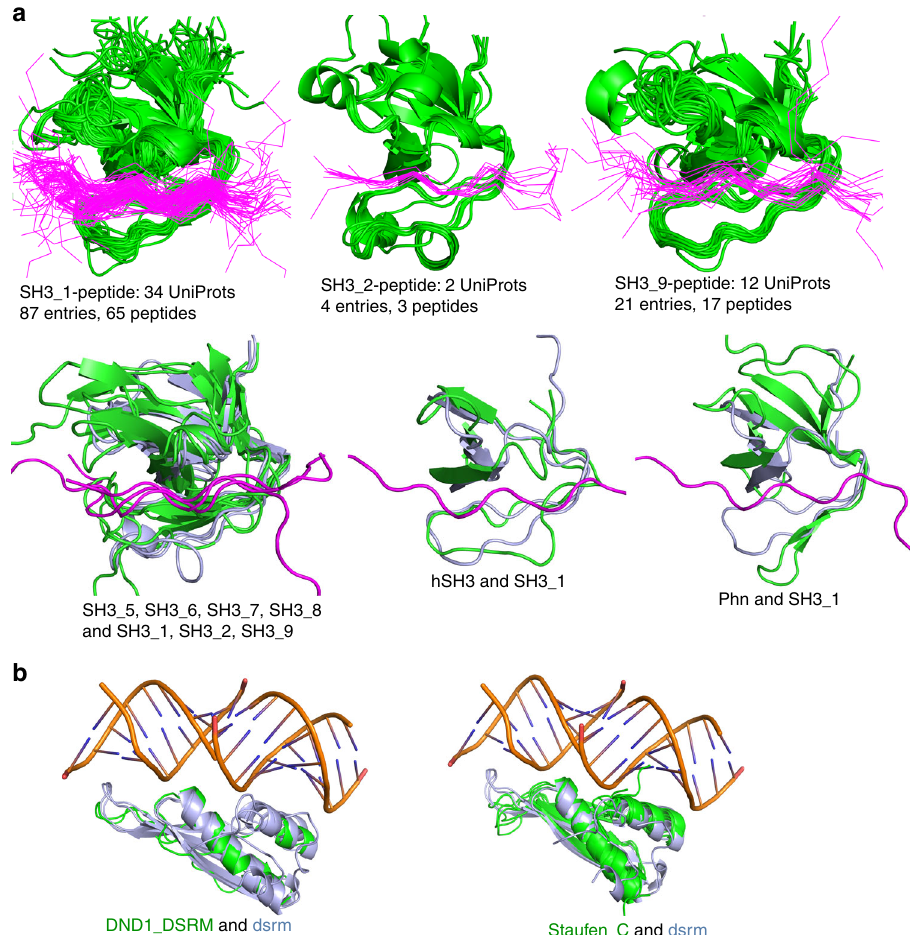
Fig. 8 Peptide-binding and DNA-binding to Pfams in clans. a Models of peptide binding to Pfams in the SH3 clan. First row: SH3_1/peptide interface cluster, SH3_2/peptide cluster and SH3_9/peptide cluster. These clusters in the SH3 clan show similar peptide-binding grooves in different Pfams. Peptides are shown in lines and colored in purple. Second row: the same peptide binding groove after superpositions of the structures of SH3_5, SH3_6, SH3_7, SH3_8, hSH3 and Phn (colored in green) onto the SH3_1, SH3_2 and SH3_9 (colored in light blue) peptide-bound structures. b Modeling Pfam-RNA binding in the DSRM clan of double-strand RNA binding proteins. The DSRM clan contains 7 Pfams, of which 4 Pfams (Dicer_dimer, dsrm, Rad52_Rad22 and Ribosomal_S5) have RNA-bound structures in the PDB. Pfams DND1_DSRM (1 UniProt: DCL1_ARATH